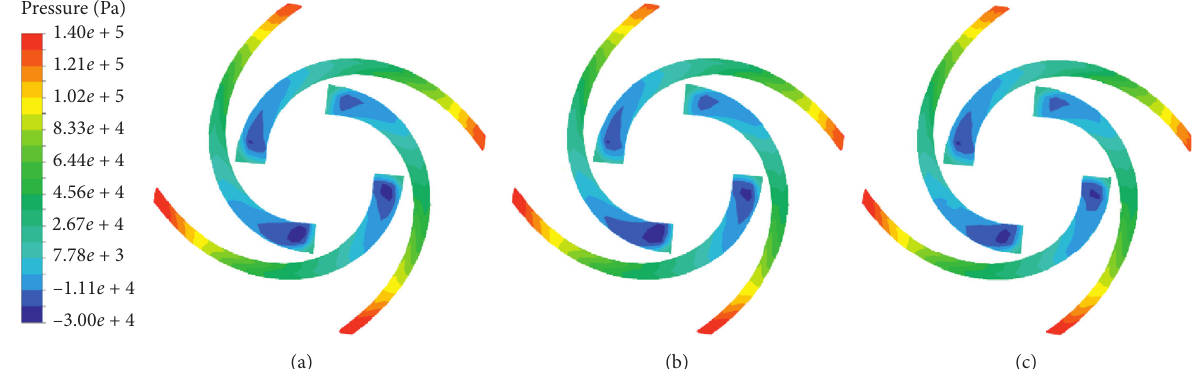
Figure 11: Pressure distribution on the suction surface of the impeller: (a) 5mm, (b) 10mm, and (c) 15mm.